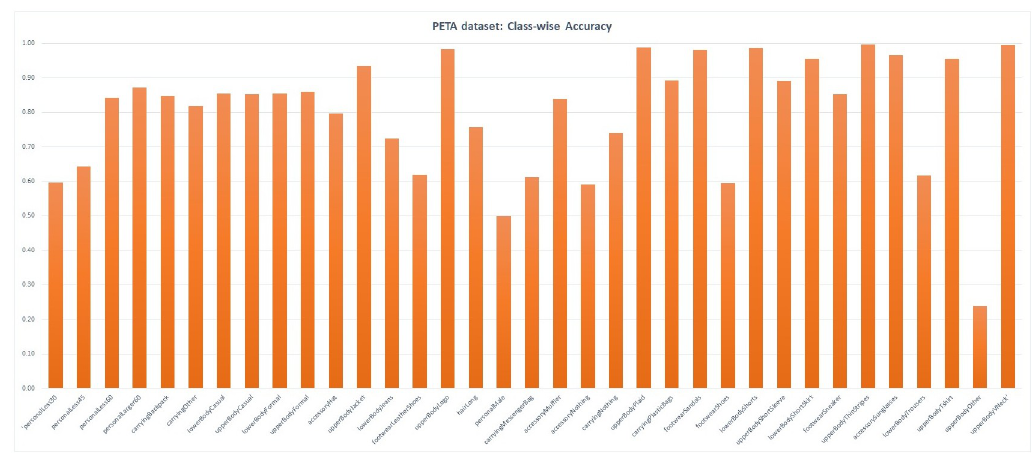
Fig 4. Class-wise accuracy—PETA dataset: The figure shows the obtained class-wise accuracy. The highest accuracy is for the class upperBodyThinStripes . The lowest accuracy is for the class upperBodyOther .